Question: Write a single sentence explaining what this figure depicts.
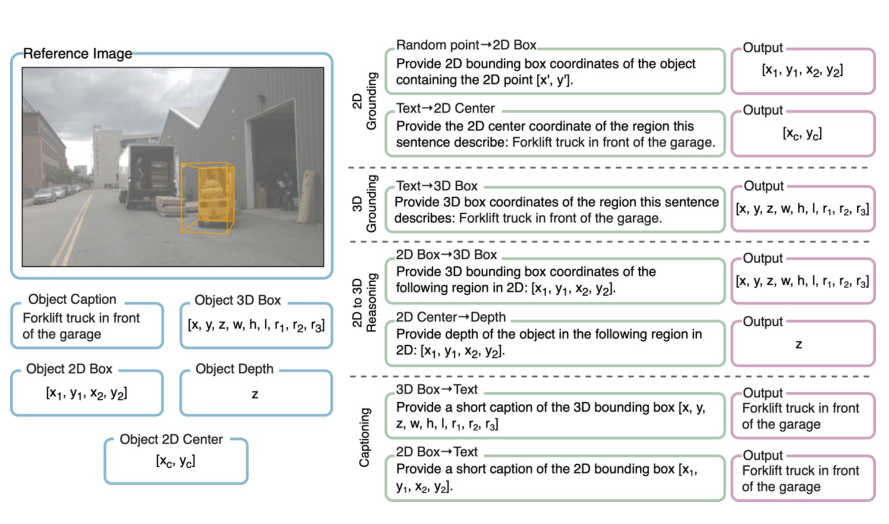
Answer: Task-scaling for versatile I/O format. Decomposing the existing label formats for 3D grounding task. A complete 3D location can be decomposed into a center point ([x, y, z]), a depth ([z]), a (projected) 2D point ([xc, yc]), and a (projected) 2D box ([x1, y1, x2, y2]). We define various tasks that connect among these to train versatile I/O formats. Left: available (decomposed) annotations. Right: various tasks for training.